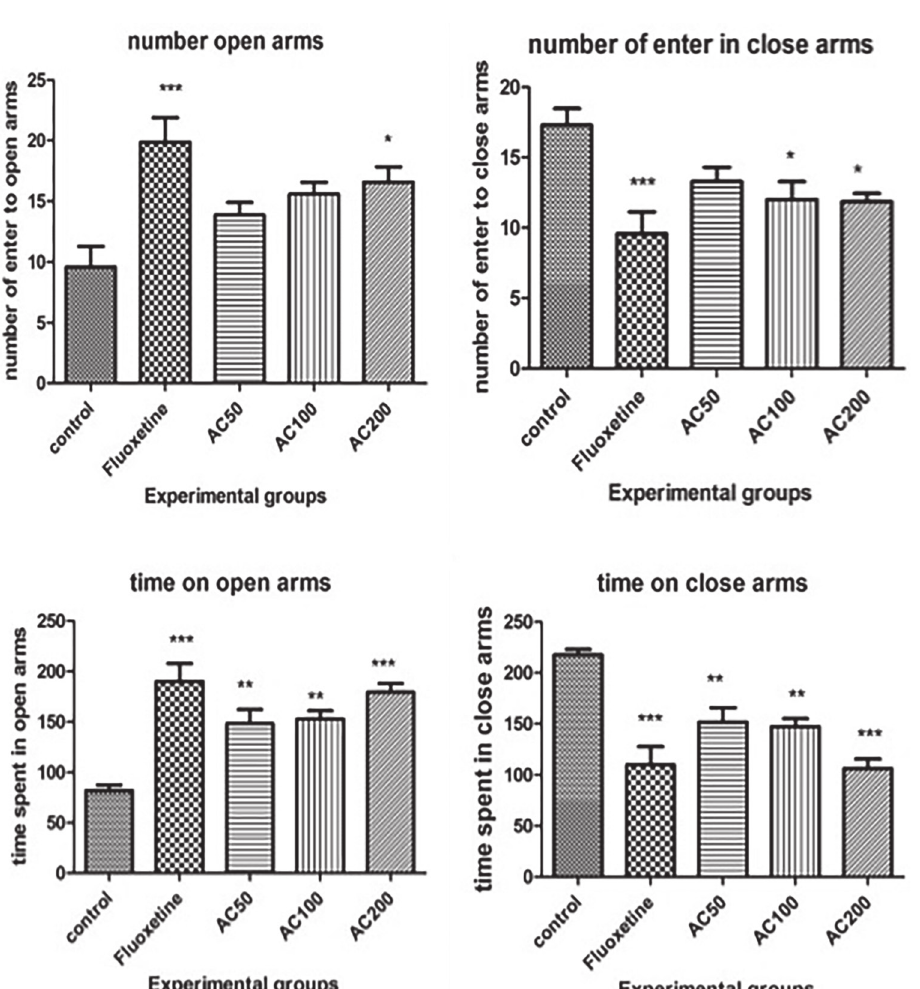
FIGURE 2 - Effect of Adiantum capillus-veneris extract on the Amount of Time Spent in the Open Arm and the Number of Open Arm Entries in Plus Maze. *** = ( P < 0.001); ** = ( P < 0.01); * =( P < 0.05) , AC: Adiantum capillus-veneris.